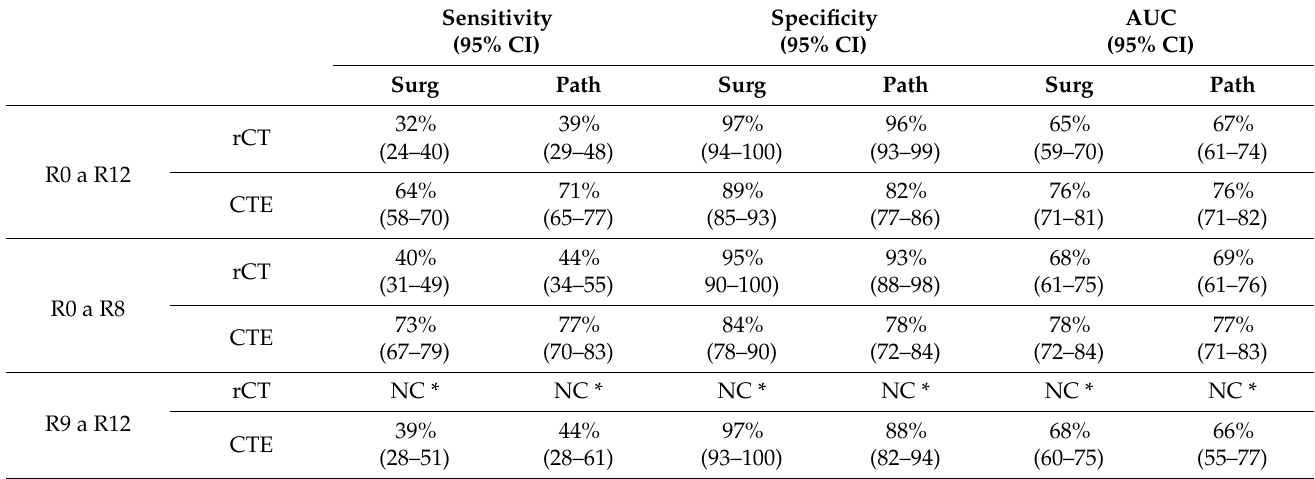
Table 3. Comparative diagnostic performance between rCT and CTE vs. surgical and pathological examination at regional level